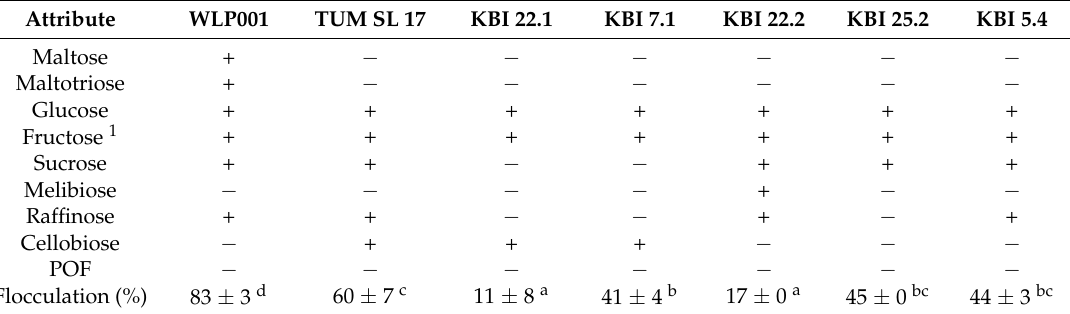
Table 2. Substrate utilization profile by BioLog YT plate test, phenolic off-flavor (POF) performance and flocculation performance of the investigated yeasts. Different superscripts of values within a row indicate a significant difference ( p ≤